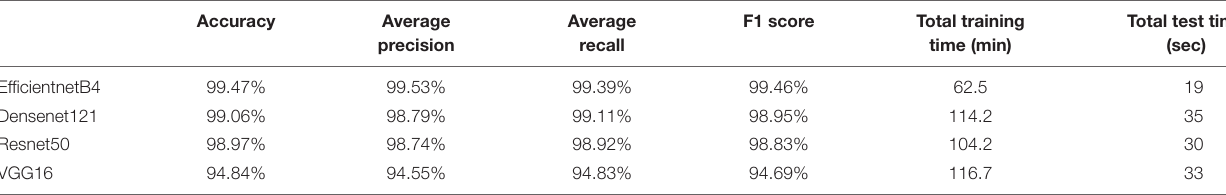
TABLE 8 | Evaluation performance on the validation sets for different CNN models.